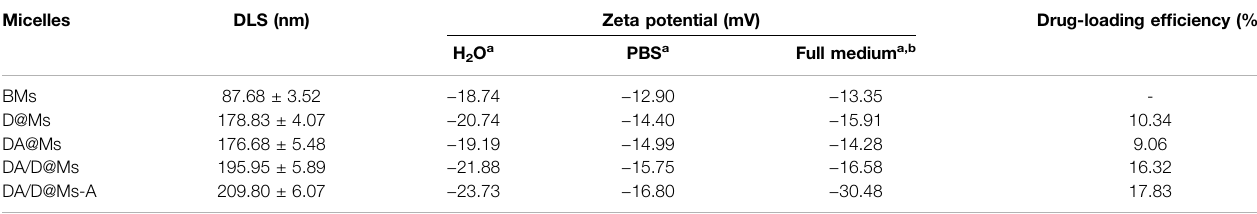
TABLE 1 | Characterization of the micelles.